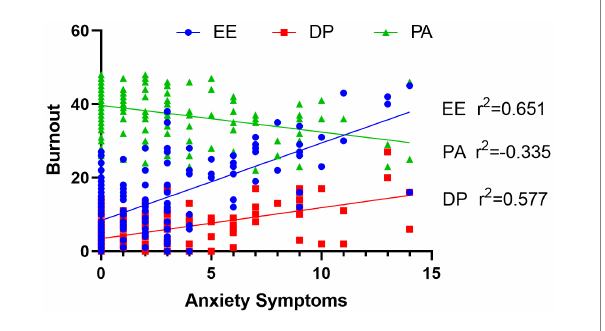
FIGURE 2 Pearson correlation between anxiety symptoms and burnout.